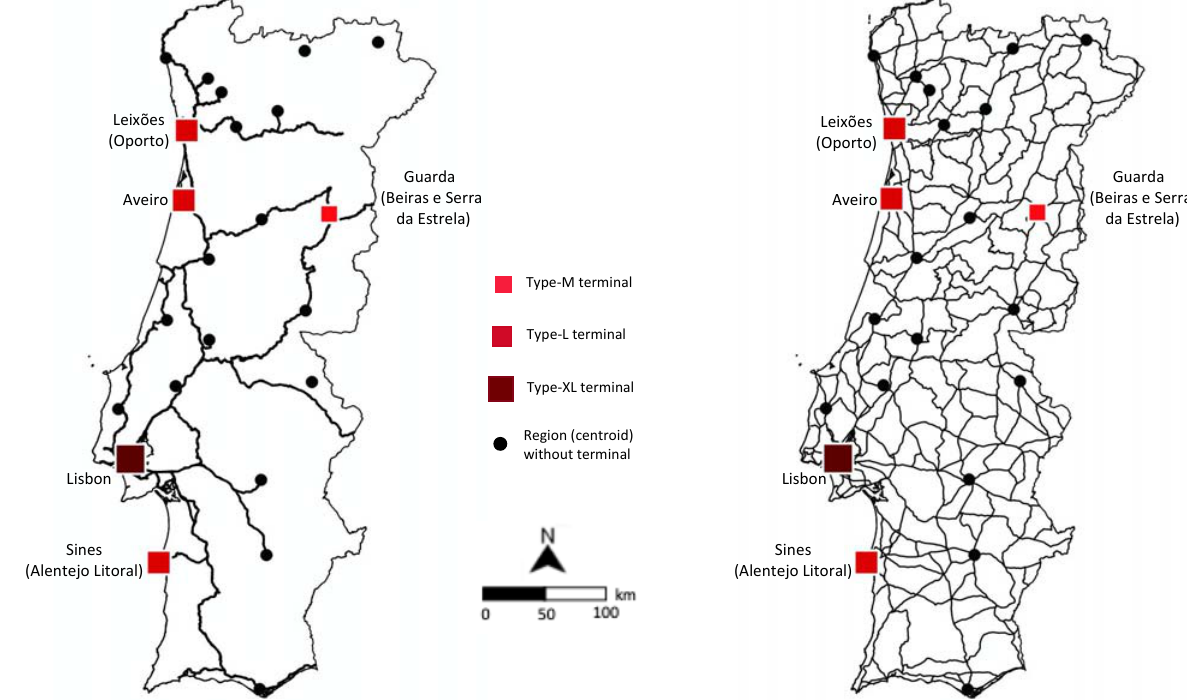
Figure 7. Rail network ( left ) and road network ( right ) of Portugal, and existing rail-road intermodal terminals.